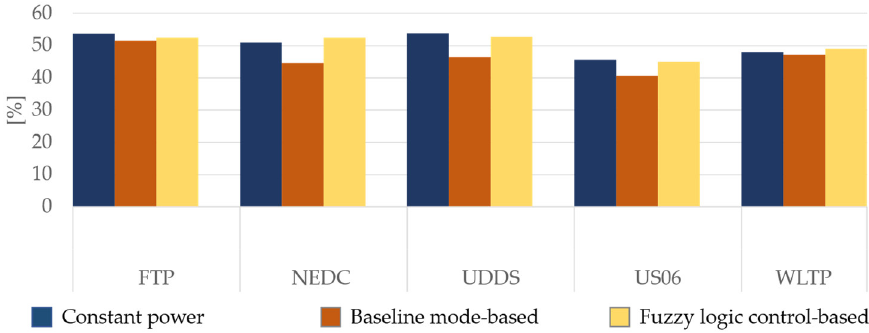
Figure 16. Comparison of fuel cell system efficiency [%].